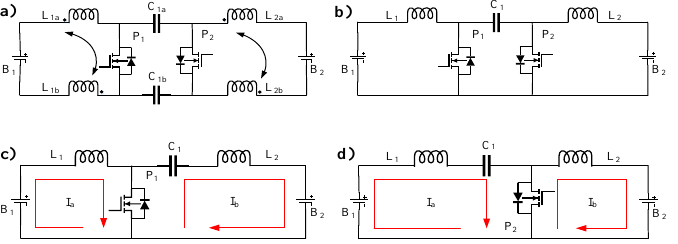
Figure 4. ( a ) Bidirectional Cuk converter; ( b ) simplified circuit; ( c ) Stage 1 operating state; and ( d ) Stage 2 operating